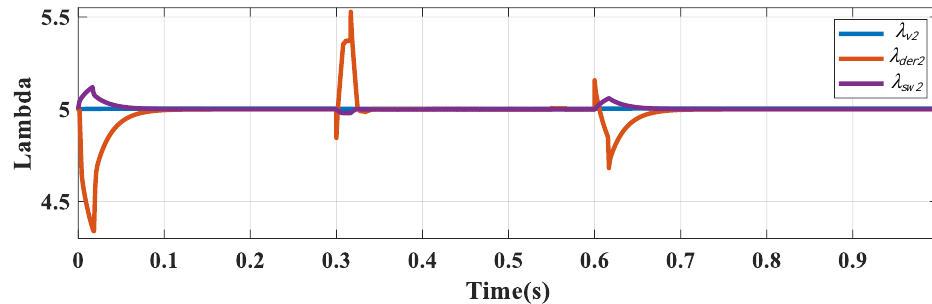
Figure 28. Study 4: generated weighting coefficients for FCS-MPC in DG2.